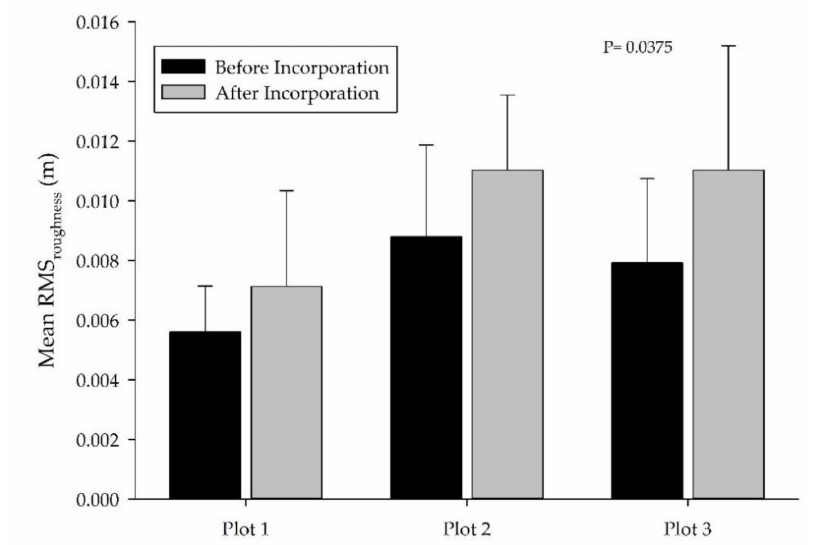
Figure 6. Arithmetic mean RMS roughness (m) of the measured profile before and after the incorporation of the nonwoven. n = 14. The measurement was performed by the feeler wheel. The error bar is the standard deviation. The p -value shows the paired Tukey test for mean RMS roughness before and after the incorporation calculated for all three plots.